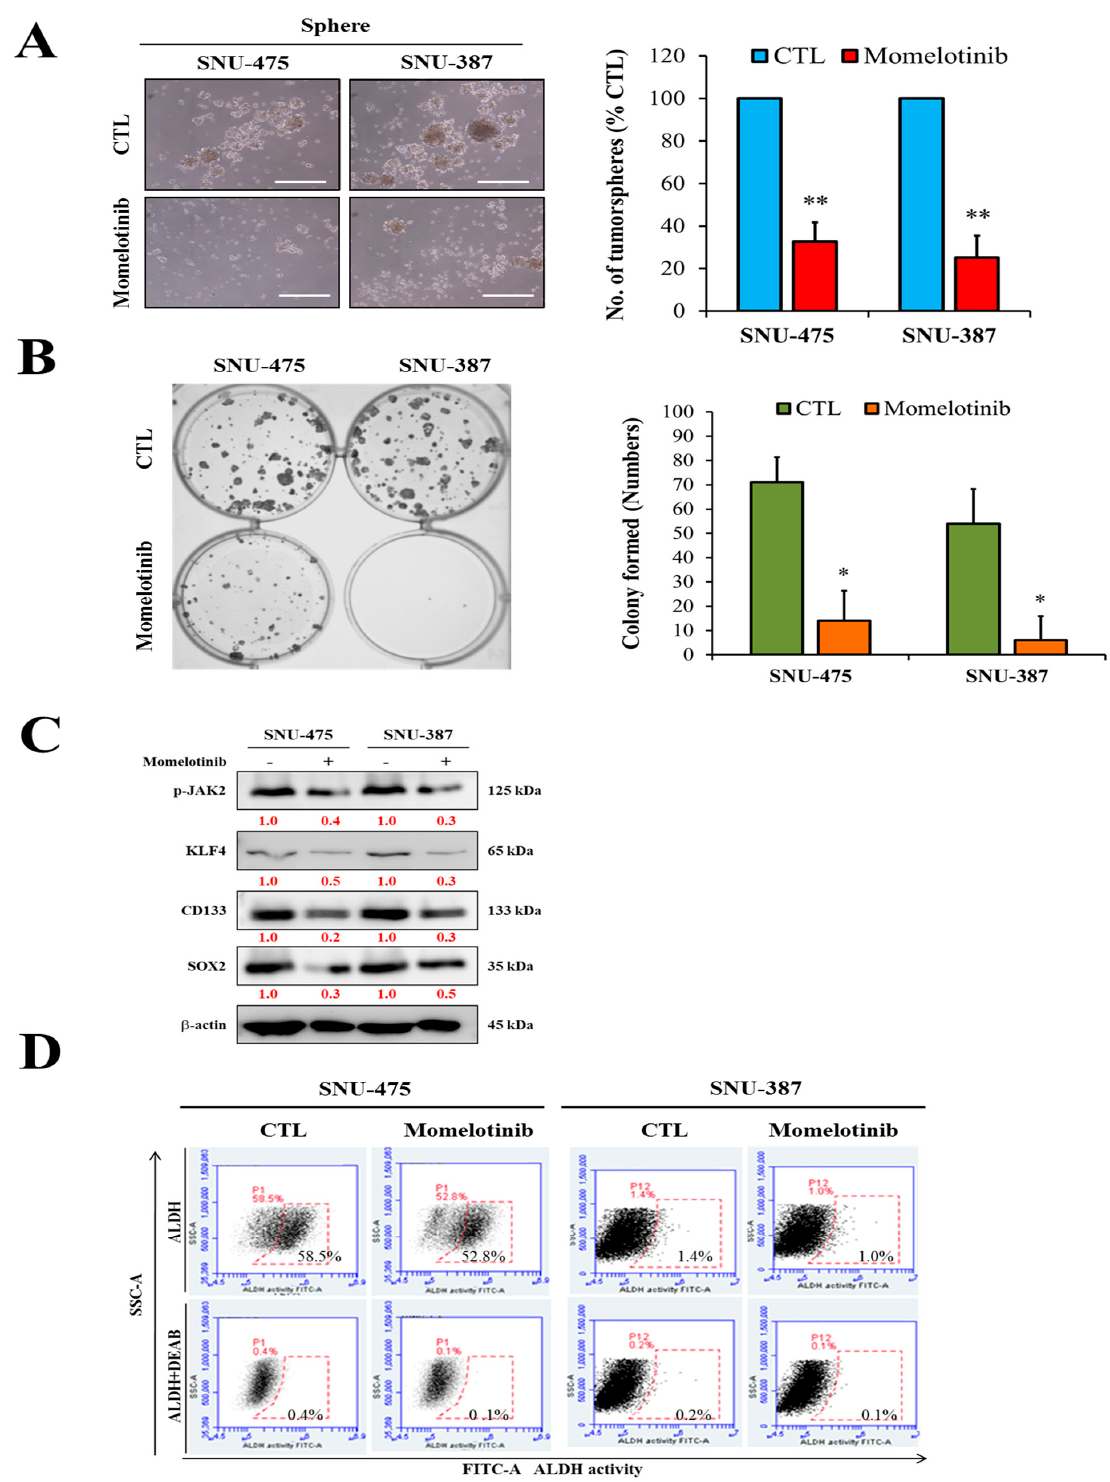
Figure 4. Momelotinib suppresses the stem cell-like phenotype of vHCC. ( A ) Tumorsphere-forming ability of SNU-475 and SNU-387 cells and graphical quantitation compared with their untreated control counterparts. ( B ) The colony-forming ability of SNU-475 and SNU-387 cells and quantitation compared with their treated and untreated control counterparts. ( C ) Protein and mRNA expression of stemness markers under treatment with momelotinib. β -actin was used as a loading control. ( D ) ALDEFLUOR assay showed that momelotinib treatment prominently reduces the activity of ALDH1 in SNU-475 and SNU-387 cells in a dose-dependent manner. The momelotinib treatment dose and time with 5 µ M and 48 h. * p < 0.05; ** p < 0.01. Scale bar: 50 µ